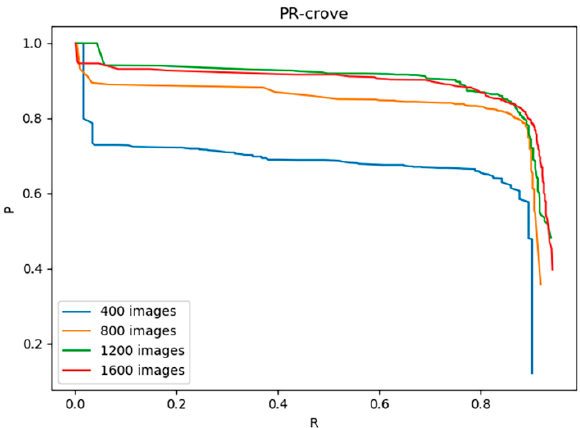
Figure 20. P-R curves of the model trained with di ff erent numbers of images.